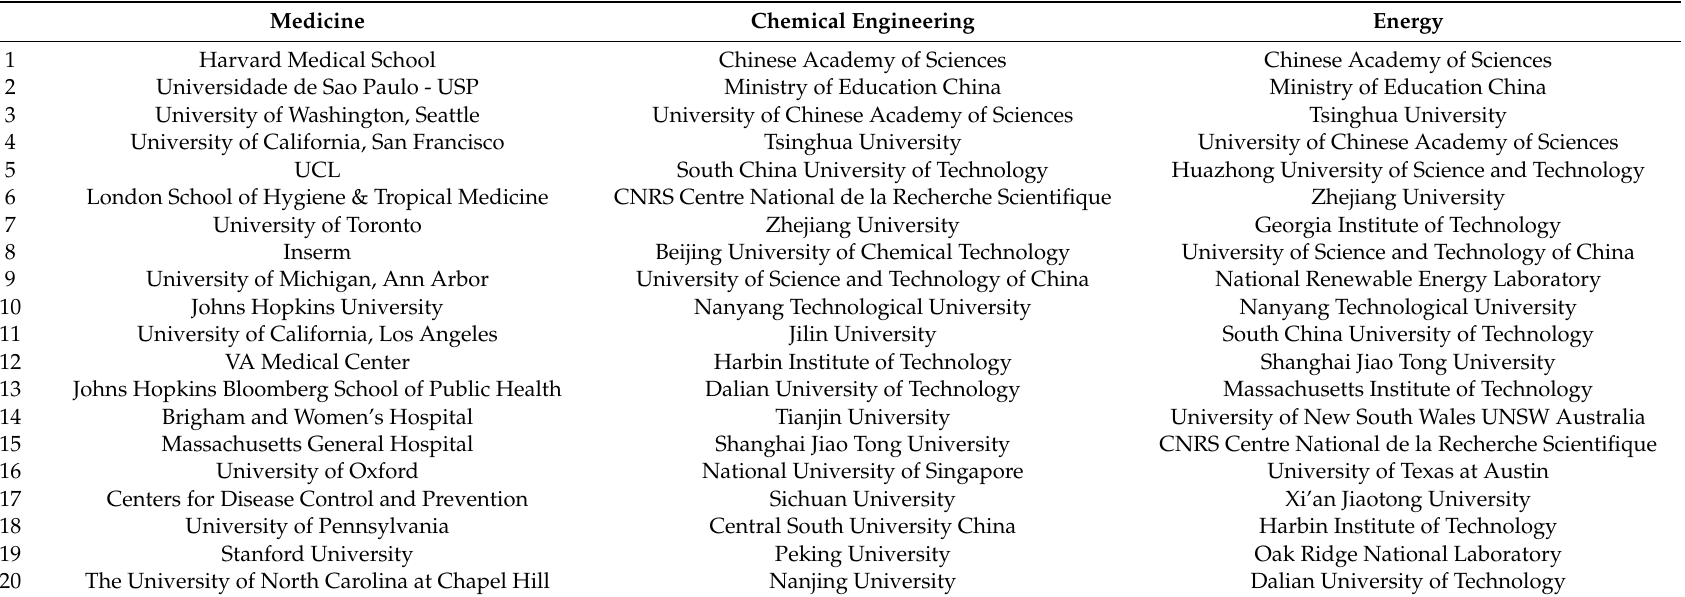
Table 6. Worldwide publications by a ffi liation / university on low cost for the categories from 6 to 8.